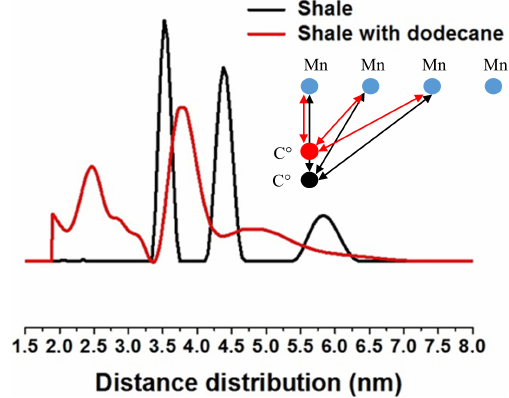
(cid:113) )–manganese distances in